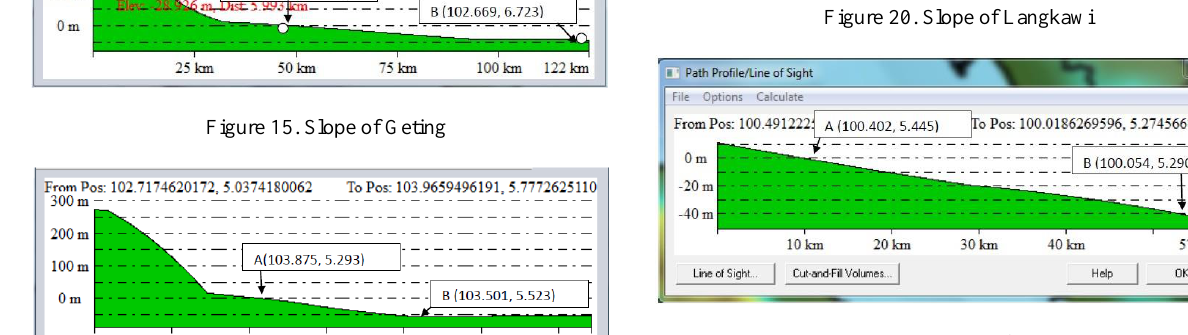
Figure 21. Slope of